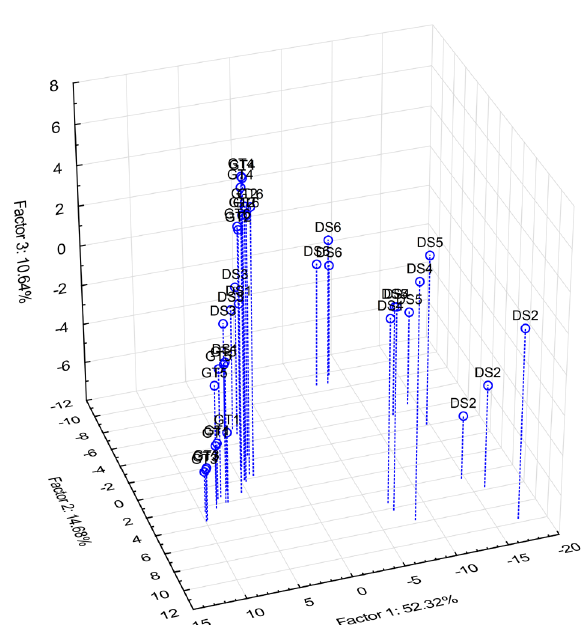
Figure 4. Projection of the investigated extracts on the space of the first three principal